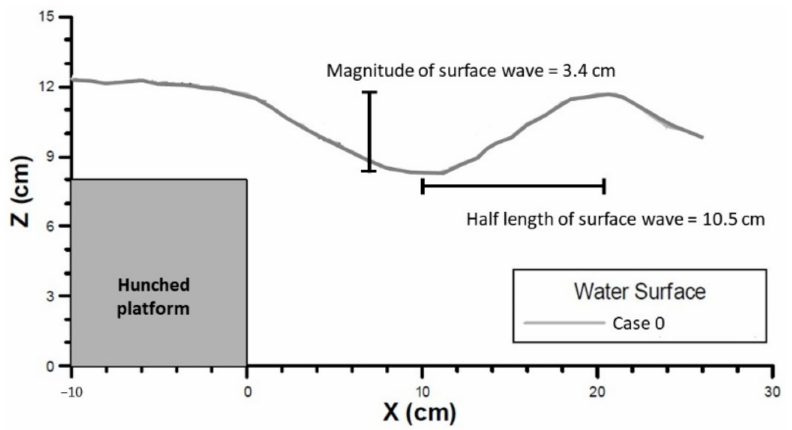
Figure 9. Water surface of Case 0 (without CKAW) after the pier scour reached an equilibrium state.